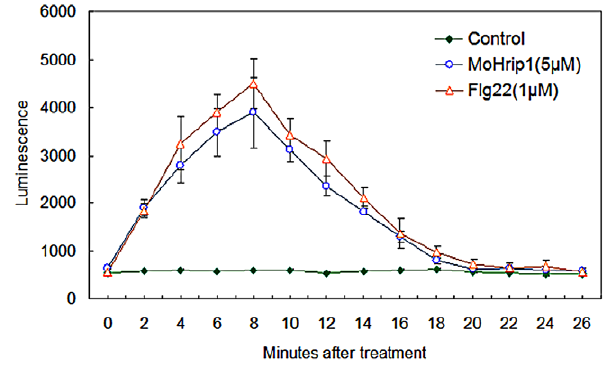
Figure 7. ROS generation induced by MoHrip1 in rice. A H 2 O 2 burst was obviously elicited by MoHrip1 (dissolved in sterile distilled water) or flg22 (positive control, dissolved in sterile distilled water) within 10 minutes in rice leaves, but no H 2 O 2 burst was detected in the samples treated with sterile distilled water (negative control). After 20 minutes, the level of ROS production in MoHrip1- or flg22-treated obtained in three independent experiments.